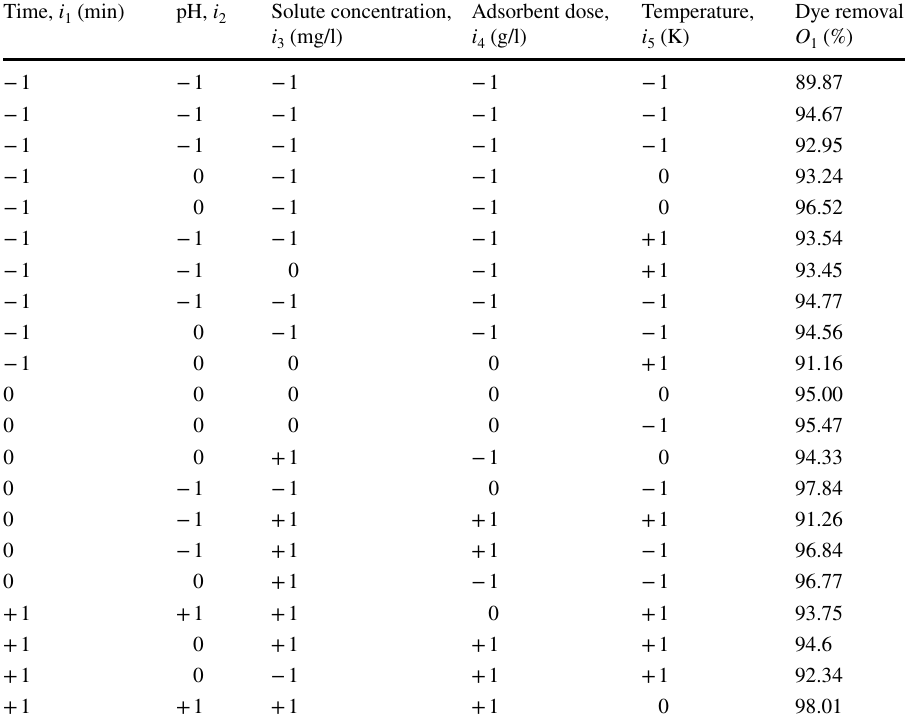
Table 2 Various variables with their coded levels with response variables using central composite design